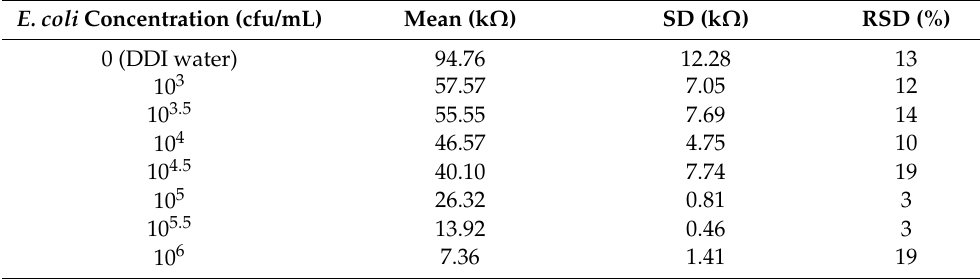
Table 1. The repeatability of the ID µ E sensor on the E. coli sample with concentrations ranging from 10 3 to 10 6 cfu/mL at an optimal measurement frequency of 1.3 kHz. E. coli Concentration